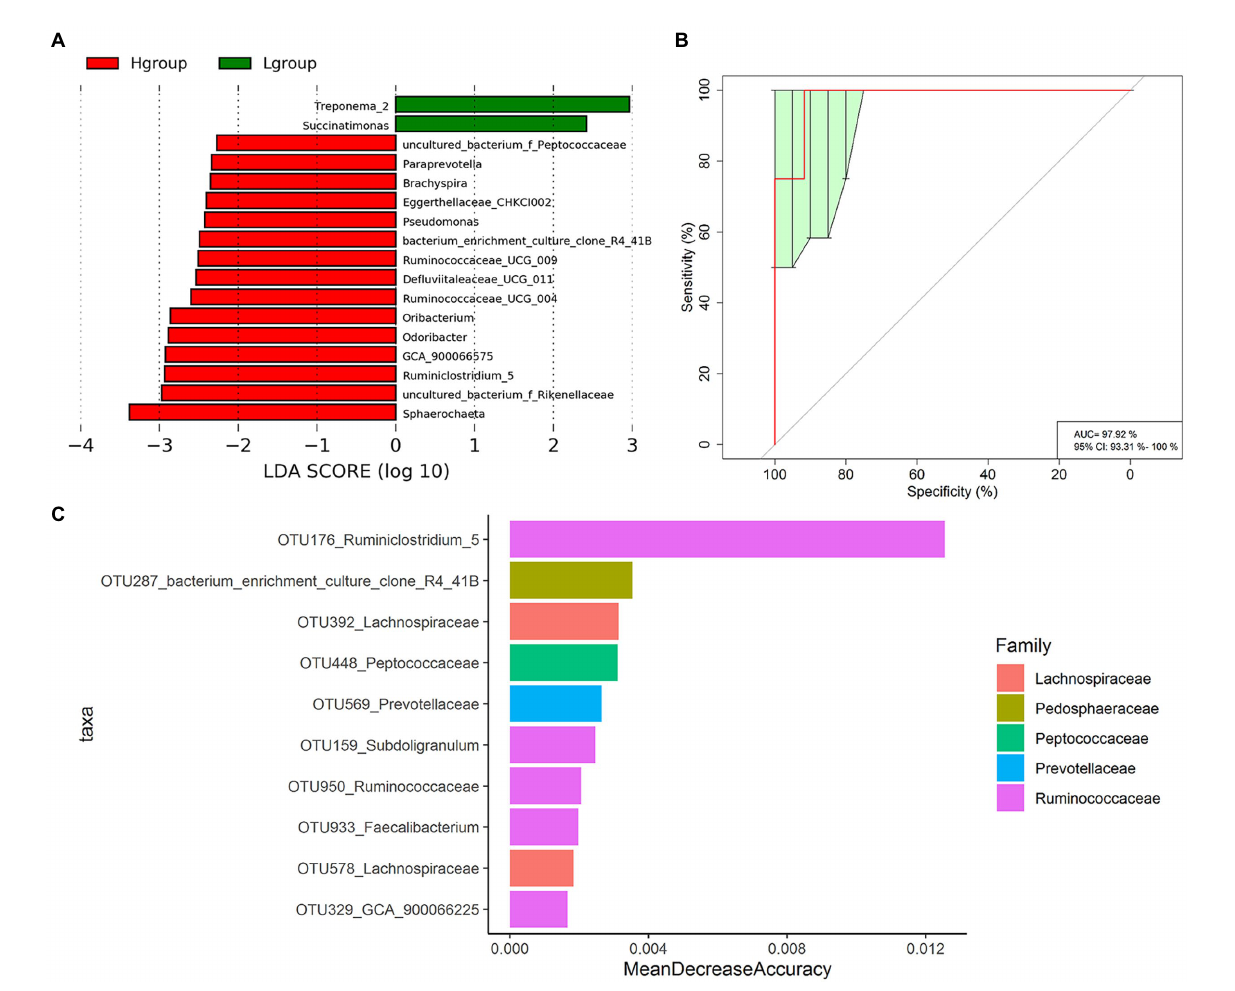
FIGURE 4 Specific OTUs of cecal microbiota related to market-weights of Qiandongnan Xiaoxiang chickens at 160 ± 3 days of age ( n = 24). (A) LEfSe analysis of cecal microbiota members associated with H group and L group chickens at the genus level. (B) Receiver operating curves (ROC) for H and L